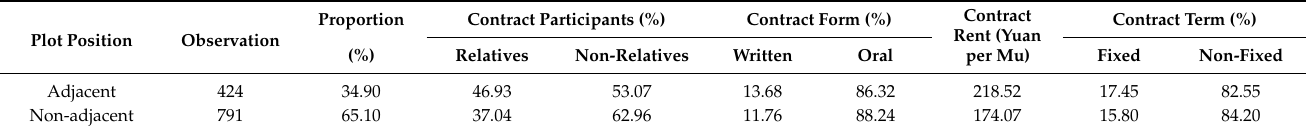
Table 3. The relationships between the position of plots rented in and farmland contract choice.